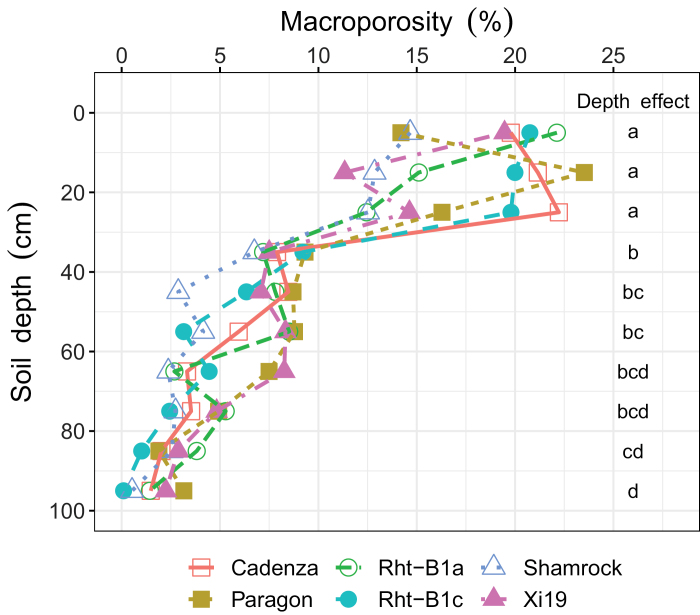
Soil macroporosity profiles of different wheat genotype treatments to a depth of 100 cm. Different letters below ‘Depth effect’ indicate significant difference of soil macroporosity between the corresponding soil depth (P<0.05).